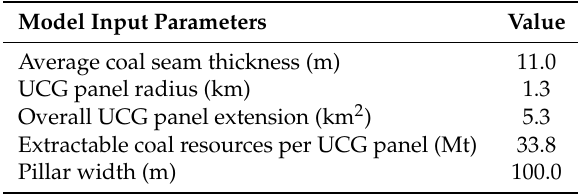
Table 5. Boundary conditions for the radial offshore UCG well design in the reference scenario